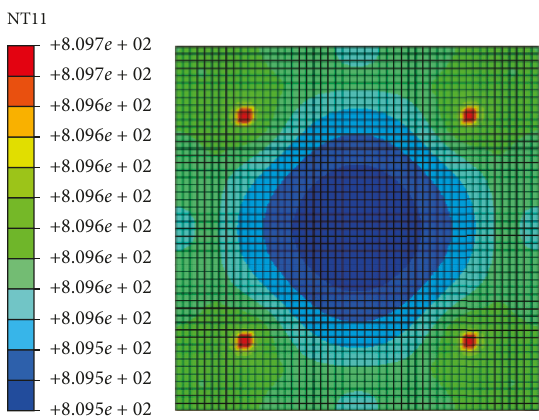
Figure 13: Substructure temperature distribution at 800s.